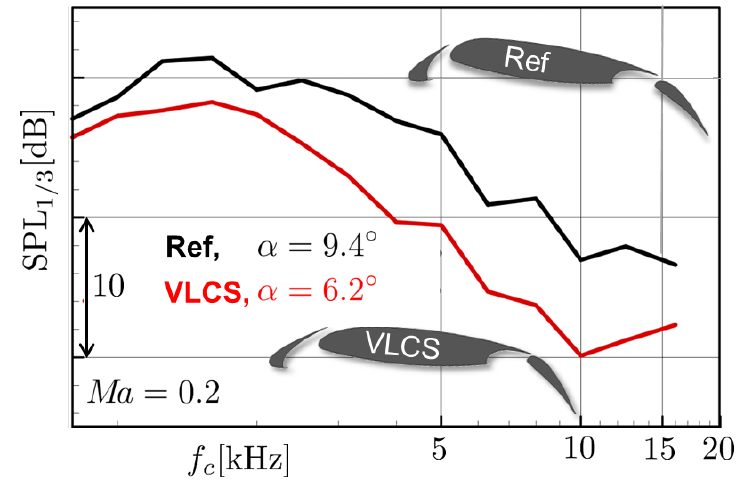
Figure 7. Noise reduction of Very Long Chord Slat (VLCS) vs. standard slat F16 geometry as determined from measurements in the NWB wind tunnel of DNW [34]. Note that the angle of attacks are chosen differently in order to generate the same overall